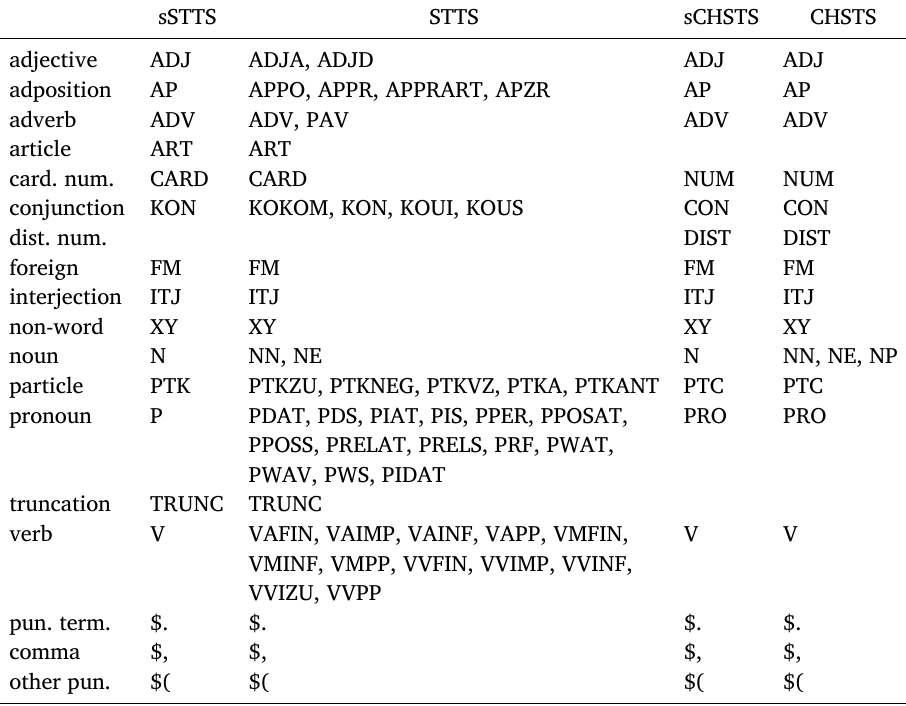
Table 7: Morphological tags used for fine-grained POS tagging. The (cid:1) la tags